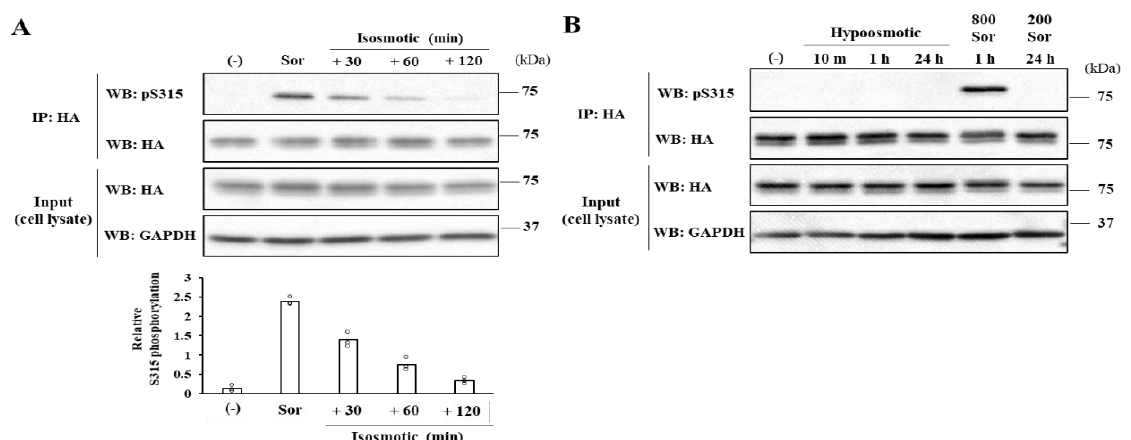
Figure 2. Effects of various osmotic stresses on the CERT S315 phosphorylation. ( A ) The osmotic stress-induced elevations of the S315 phosphorylation are reversibly decreased. After the incubation in a medium containing 800 mM sorbitol for 1 h, CERT KO/shCERT HeLa cells expressing HA-CERT WT with near endogenous level were further incubated in an isosmotic medium for the indicated times. The eluates of the immunoprecipitated samples and the total cell lysates were immunoblotted with the indicated antibodies. The bars represent the means (n = 3), and the white circles indicate the values from each experiment. ( B ) Hypoosmotic or mild but prolonged hyperosmotic stresses do not augment the S315 phosphorylation. For hypoosmotic stress, CERT KO/shCERT HeLa cells expressing HA-CERT WT with near endogenous level were incubated in a medium diluted with distilled water by two-thirds for the indicated times. For relatively mild (500 mOsm) but prolonged hyperosmotic stress, cells were treated with 200 mM sorbitol for 24 h. The eluates of the immunoprecipitated samples and the total cell lysates were immunoblotted with the indicated antibodies. Two independent experiments were carried out, and similar results were obtained.